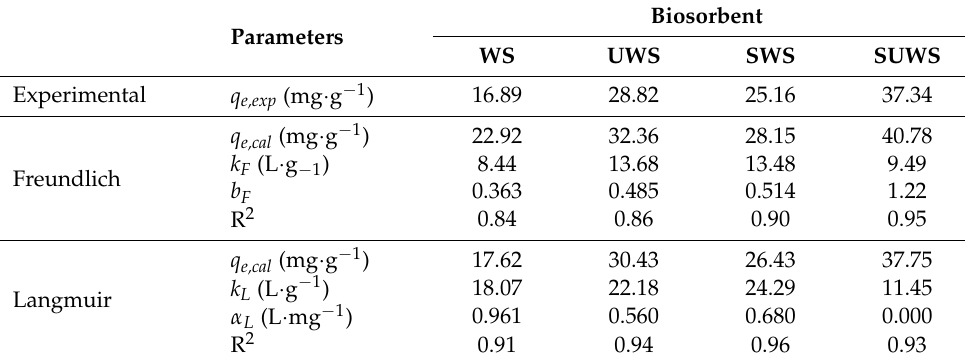
Figure 6. Isotherms for the adsorption of CV onto the biosorbents ( a ) WS, ( b ) UWS, ( c ) SWS and ( d ) SUWS. Comparison between the experimental data (points) and predictions (lines) of the Langmuir and Freundlich models. Table 7. Parameters estimated from isotherm adsorption models.